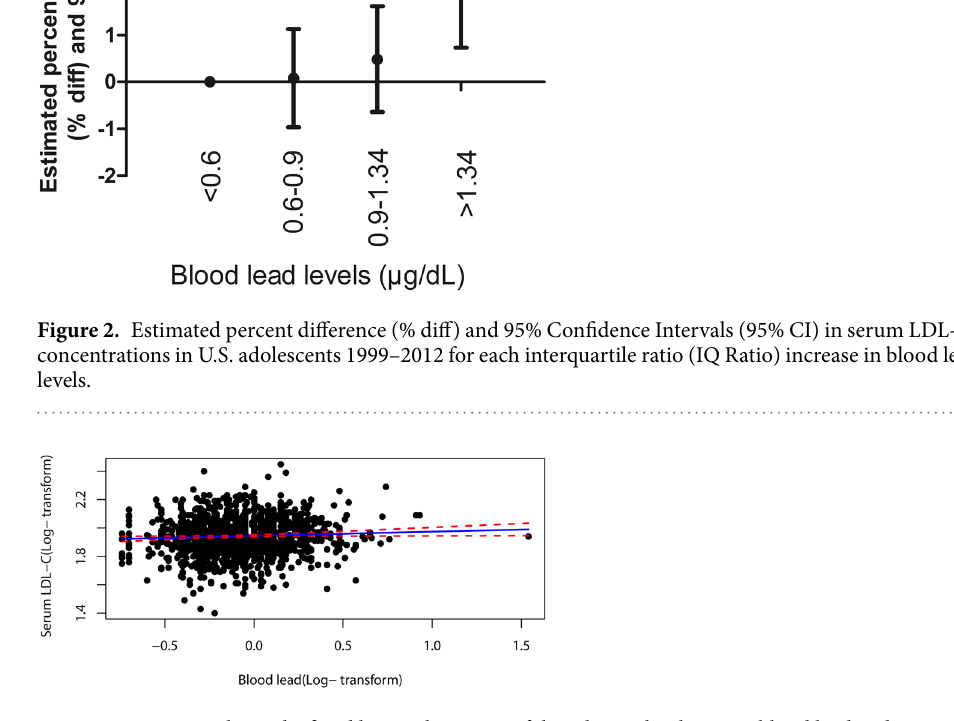
Figure 3. A scatter plot and a fitted line with 95% CI of the relationship between blood lead and LDL-C in